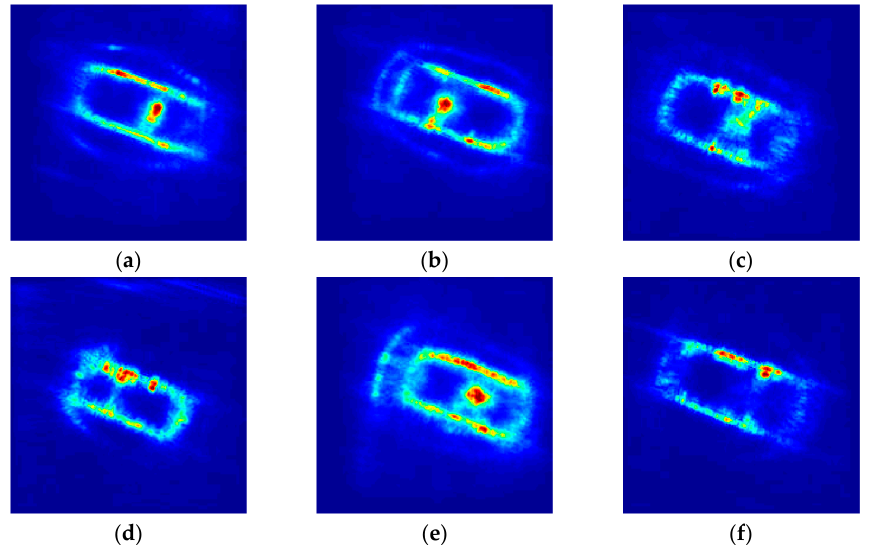
Figure 12. Examples of residual compensation imaging for six models of vehicles: ( a ) Model Chevrolet Impala LT, the label in the dataset is Fcara; ( b ) Model Mitsubishi Galant ES, the label in the dataset is Fcarb; ( c ) Model Toyota Highlander, the label in the dataset is Fsuv; ( d ) Model Chevrolet HHR LT, the label in the dataset is Mcar; ( e ) Model Pontiac Torrent, the label in the dataset is Msuv; ( f ) Model Chrysler Town & Country, the label in the dataset is Van.